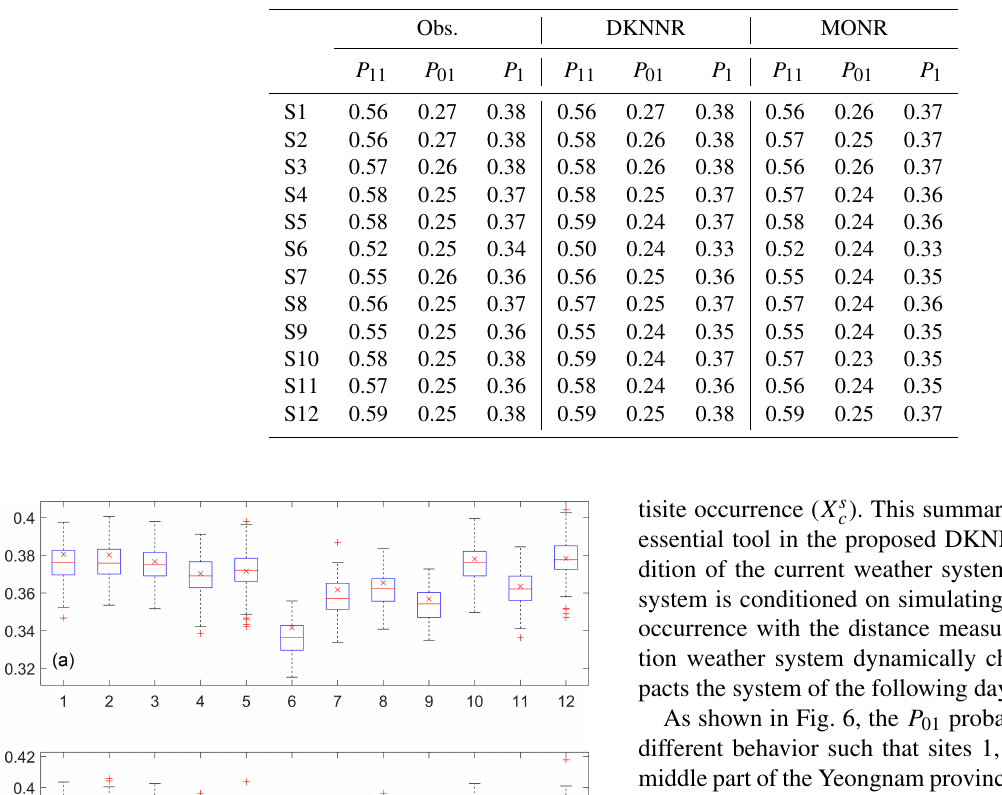
Table 2. Occurrence and transition probabilities of observed data and data simulated by DKNNR and MONR for 12 stations from the Yeongnam province, South Korea, during the summer season. Note that 100 sets with the same record length as the observed data were simulated and the statistics of 100 sets were averaged.